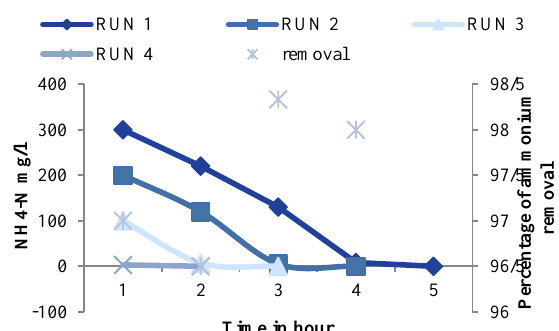
Figure 4. Ammonium concentration in the